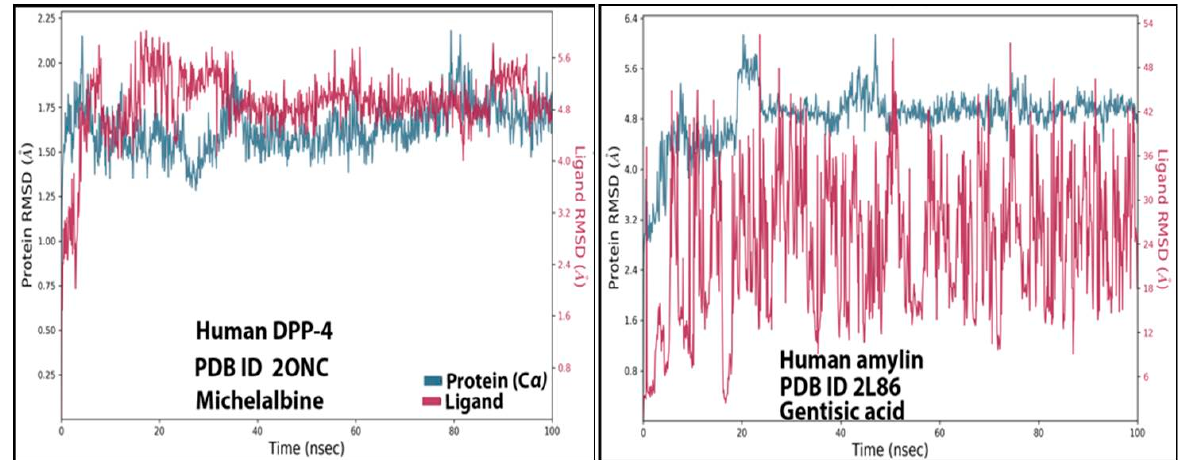
Figure 4. TheRMSD values of the complexes (human DPP-4 with michelabine and human amylin with gentisic acid).